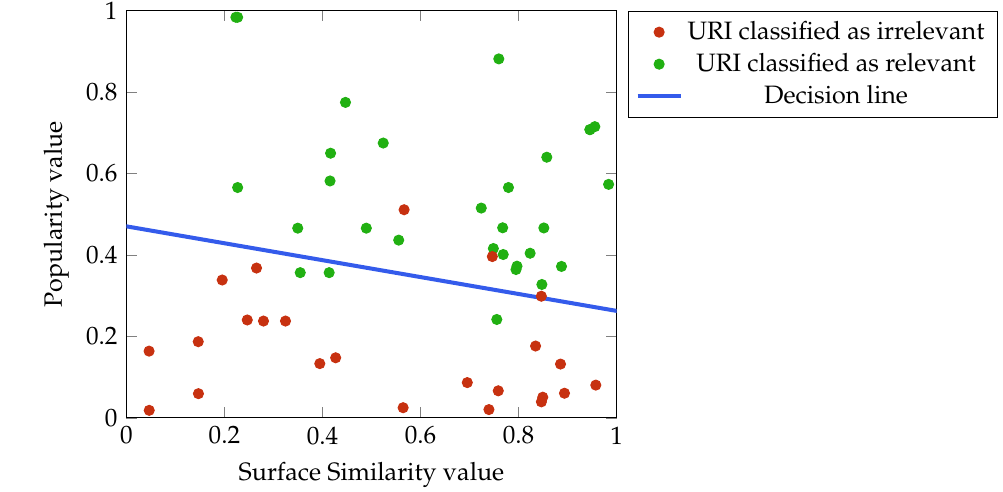
Figure 8. SVM’s training data and corresponding decision line